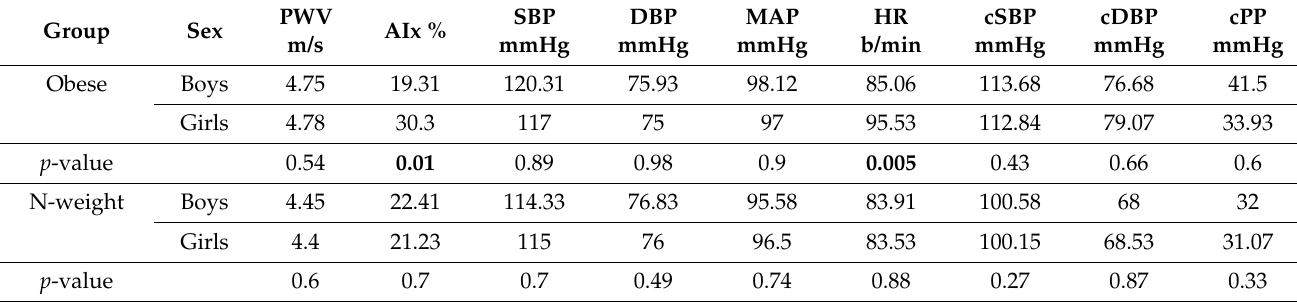
Table 4. PWA parameters by sex.